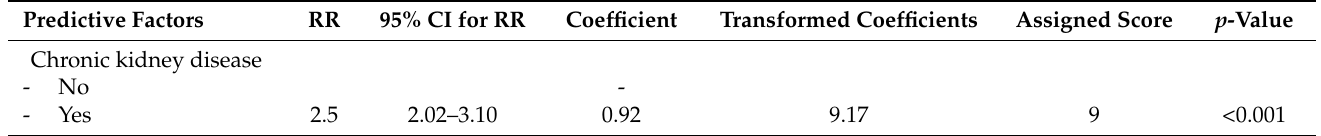
Table 2. Multivariate analysis with coefficient values of each